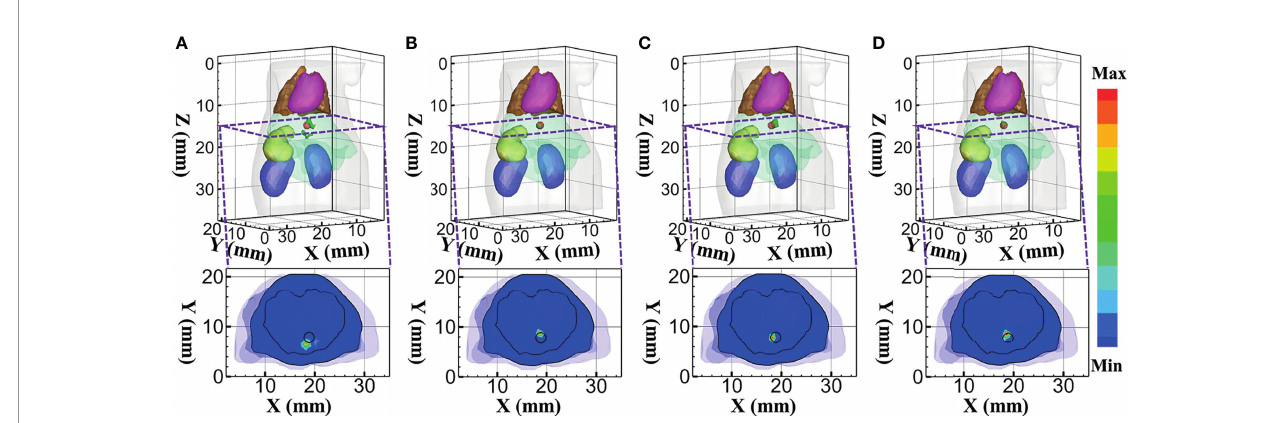
FIGURE 9 | Reconstructed results at multispectral. (A – D) 3D views of the reconstructed results and corresponding sectional images obtained by the DE-, SP 3 -, HDSM-, and MRHM-based